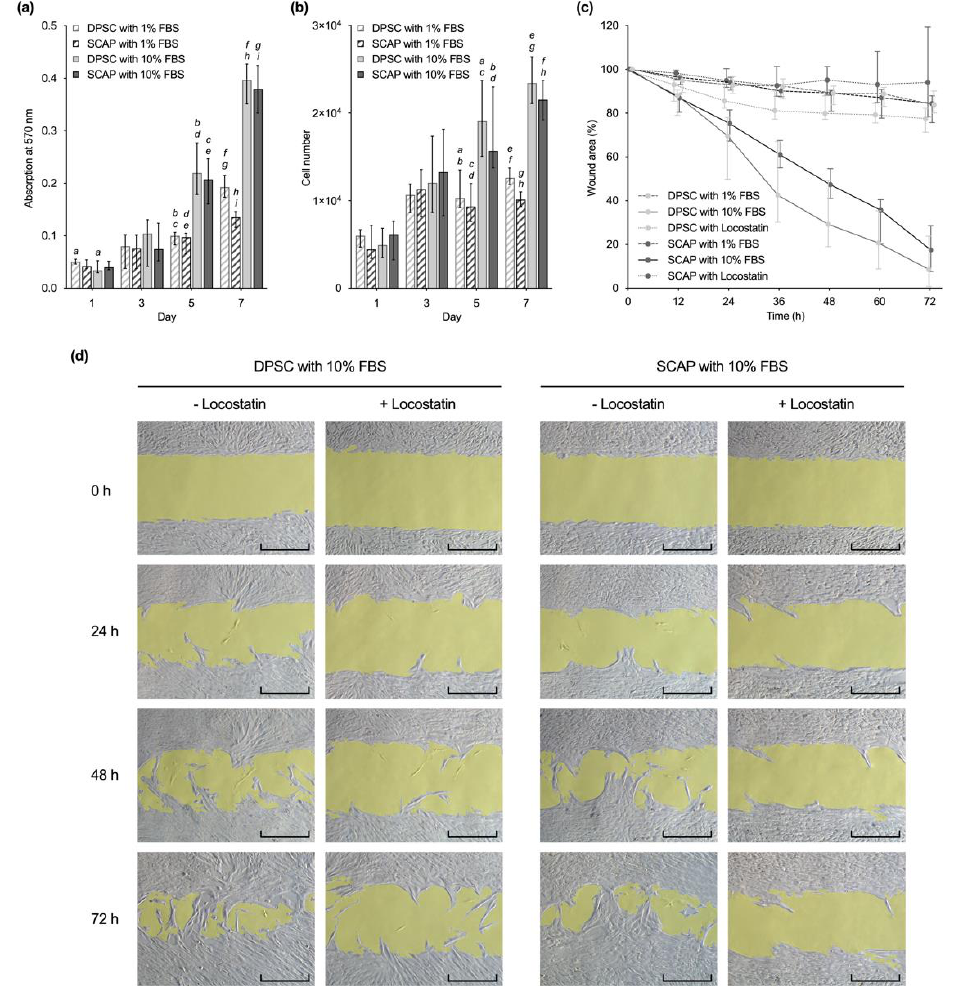
Figure 2. Comparison of ( a ) viability, ( b ) proliferation, and ( c , d ) migration of dental pulp stem cells (DPSC) and stem cells from the apical papilla (SCAP). ( a , b ) Viability and proliferation of DPSC and SCAP at different serum concentrations. Median values and 25–75% percentiles are based on three independent experiments performed in triplicates ( n = 9). For each time point, the same lower-case letters indicate bars with statistically significant difference ( p ≤ 0.05). ( c ) Cell migration of both cell types was determined over 72 h in triplicates and repeated two times ( n = 12). Medians and 25–75% percentiles were normalized to the initial wound area, which was set to 100%. ( d ) Microscopic images of gap closure (gap area highlighted in yellow) by DPSC and SCAP cultured in alpha minimum essential medium (αMEM) with 10% fetal bovine serum (FBS) with and without Locostatin over 72 h. Scale bars: 400 µm.